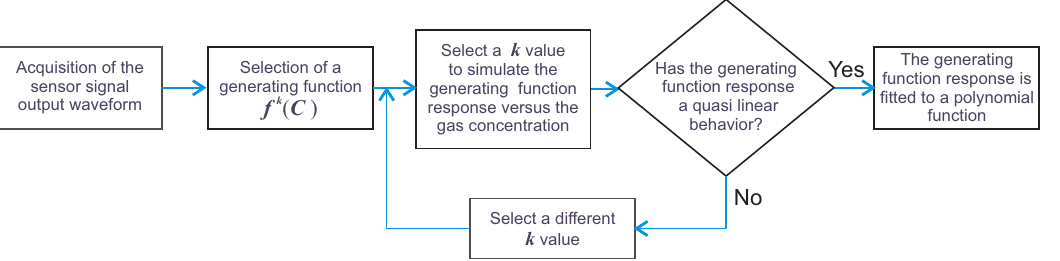
Figure 4. Flow diagram of the proposed